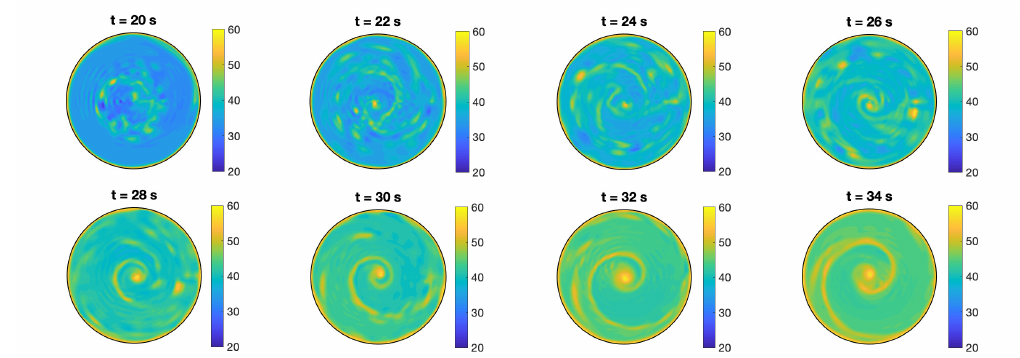
Figure 9. Contour of the predicted temperature for a top view at z = 0.0017 m for T e = 60 ◦ C and Ω = π s − 1 at different 100